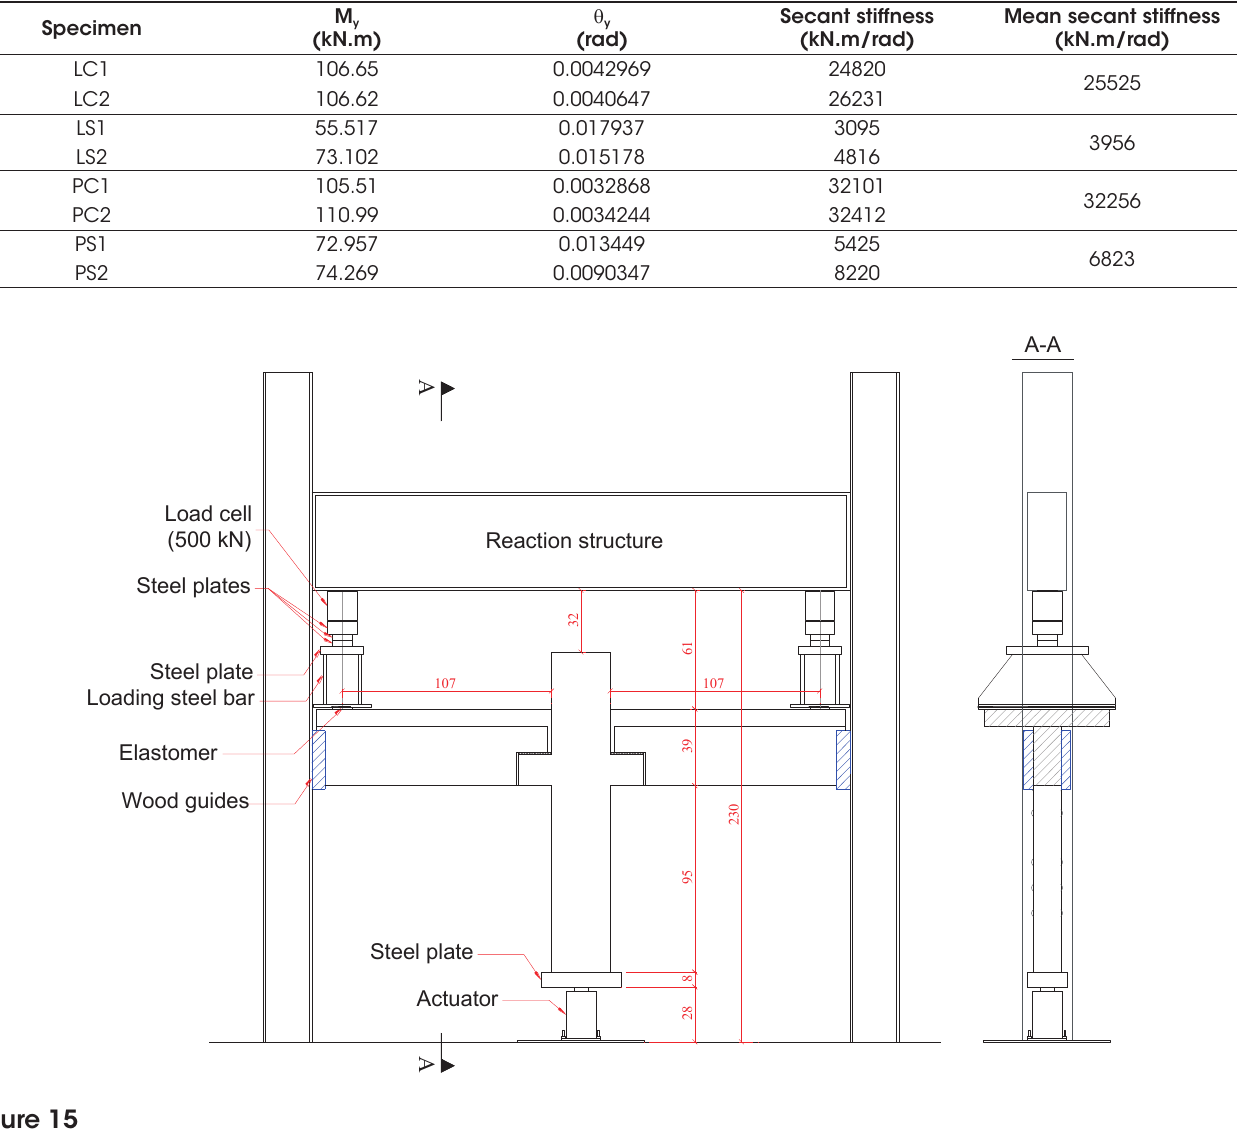
Experimental determination of the flexural secant stiffness of the beam-column connections